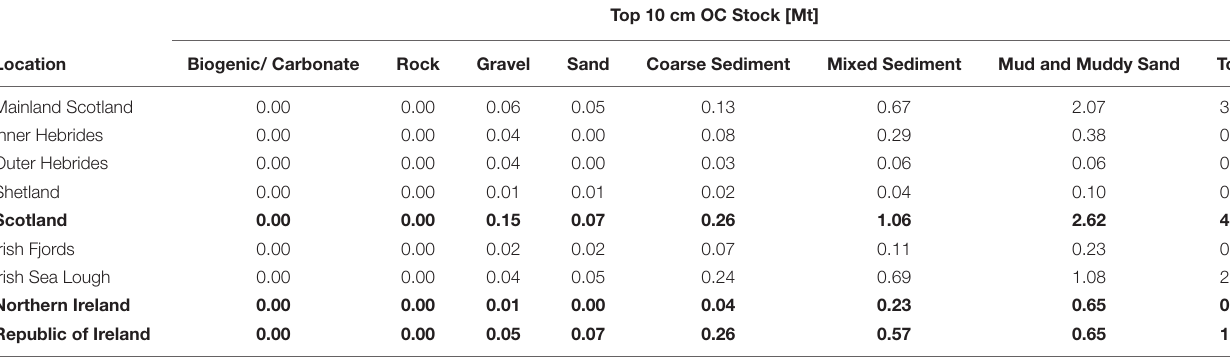
TABLE 2 | Surficial (top 10 cm) OC stocks for fjords for Scotland and Ireland broken down to regions.